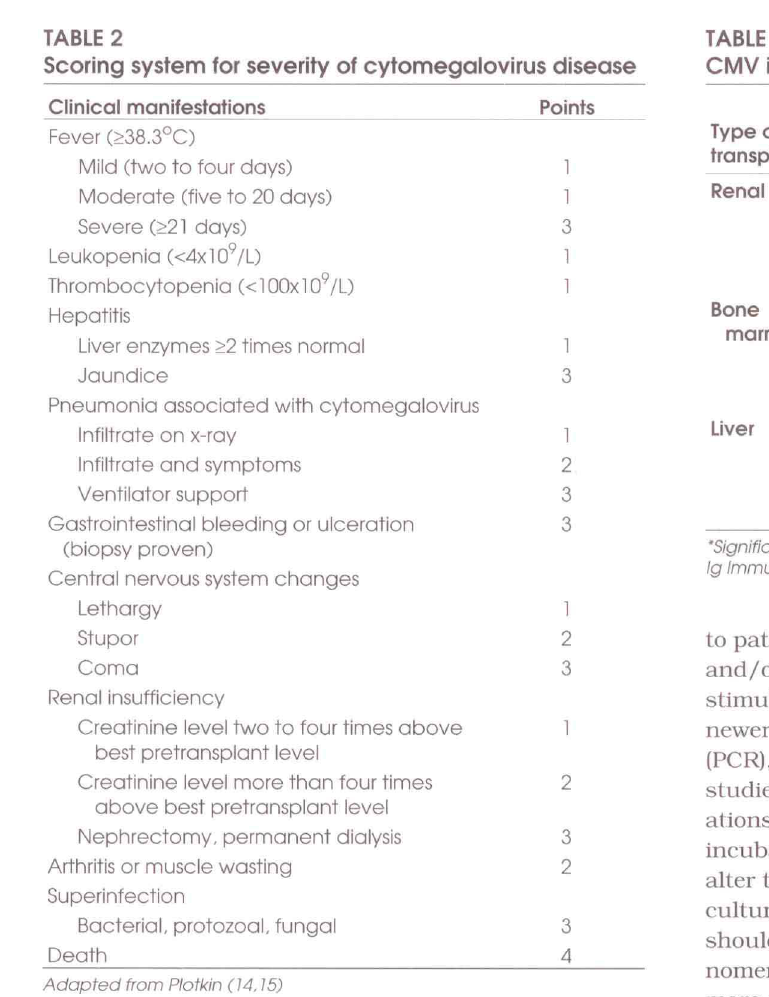
Scoring system for severity of cytomegalovirus disease CMV infection and disease at The Royal Free Hospital Type of